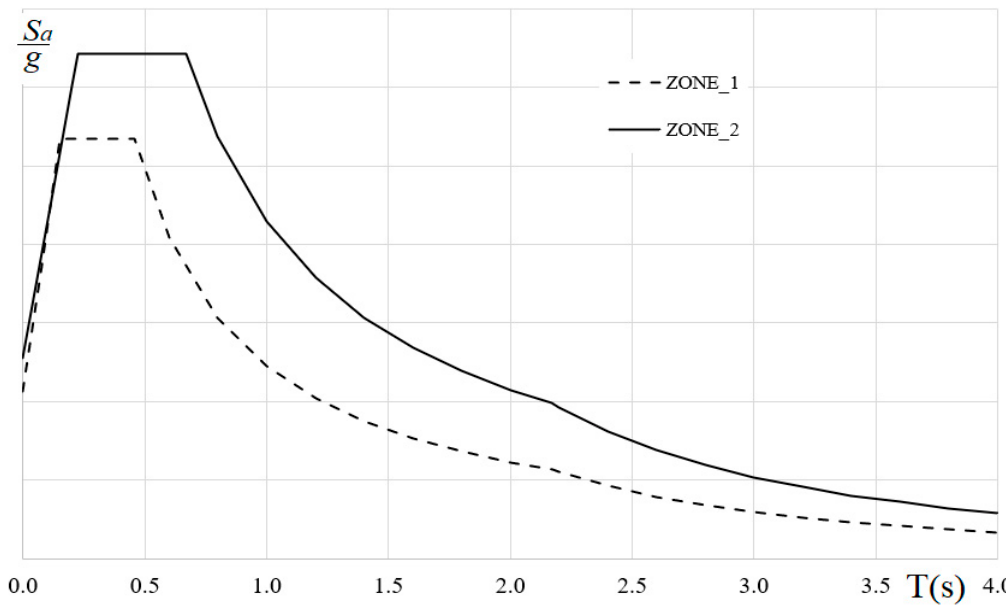
Figure 9. The considered response spectra ( α g = 1).